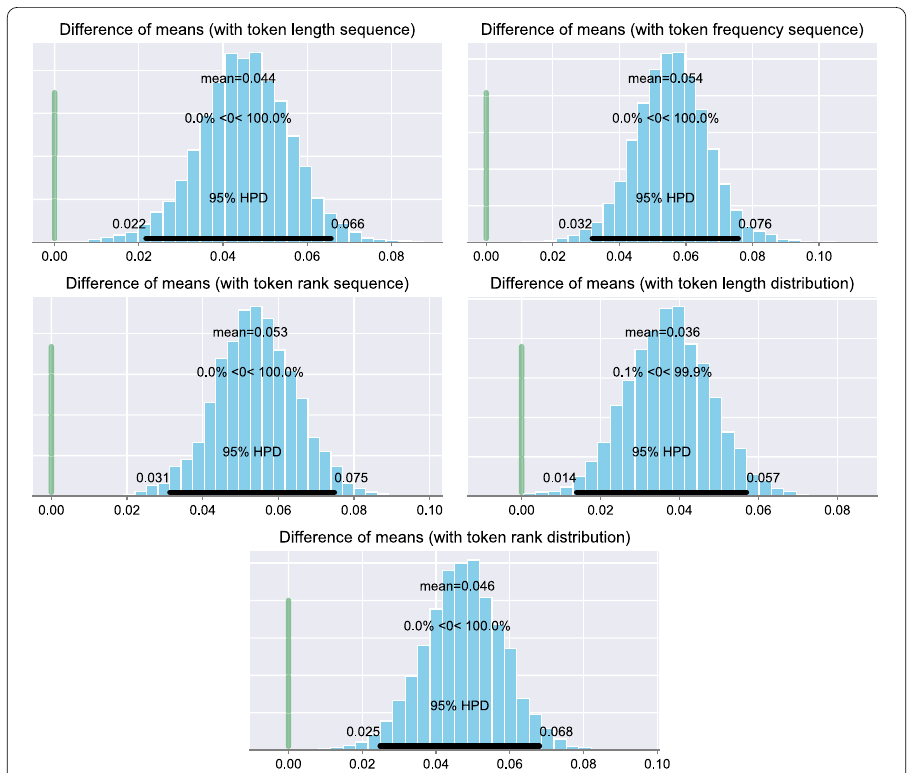
Figure 9 Posterior distributions of the differences of means between log loss values of NLP predictions alone and those with one time series features group combined. The black horizontal bar is the 95% credible